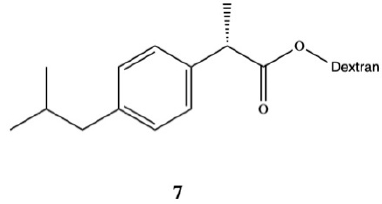
Figure 5. Dexibuprofen-dextran prodrug.